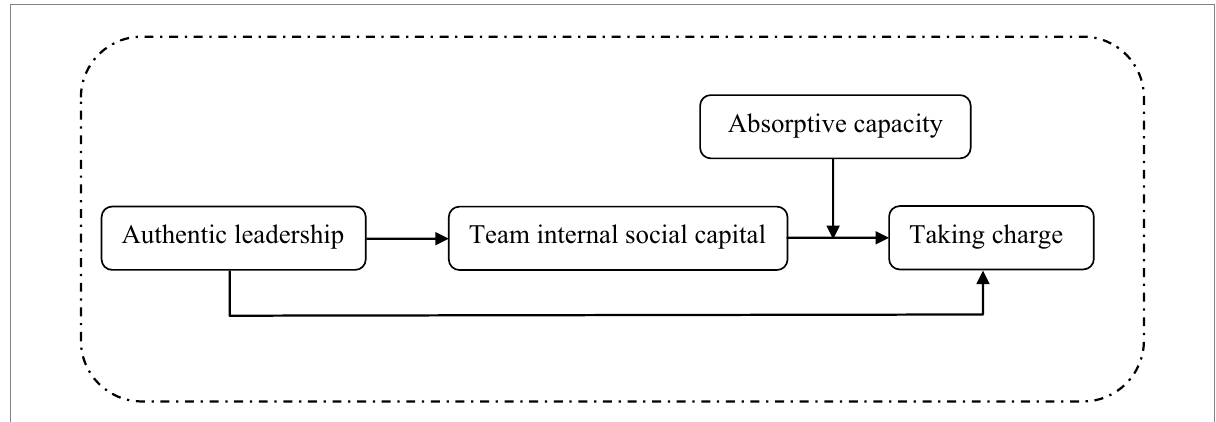
FIGURE 1 Theoretical model of authentic leadership, TISC, taking charge, and absorptive